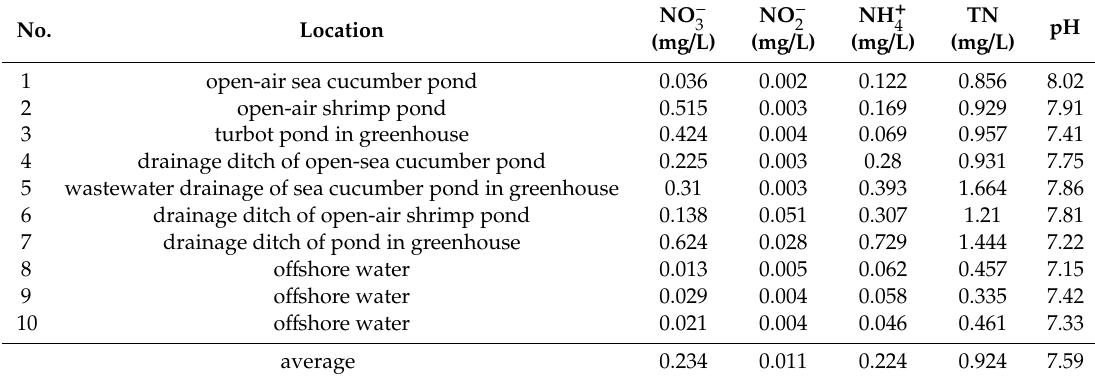
Table 7. Concentrations of N pollutants in aquaculture ponds, drainage ditches, and o ff shore